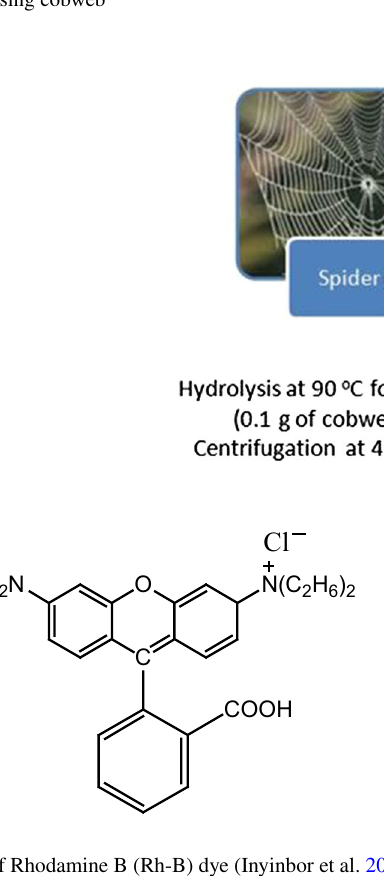
Fig. 1 Scheme for the biosyn- thesis of AgNPs using cobweb extract